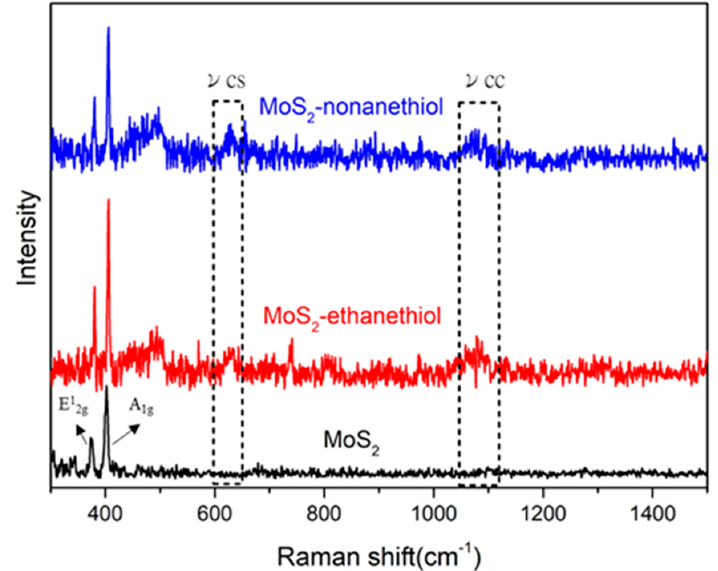
Figure 2. Raman spectra of MoS 2 and thiol-modified MoS 2 .